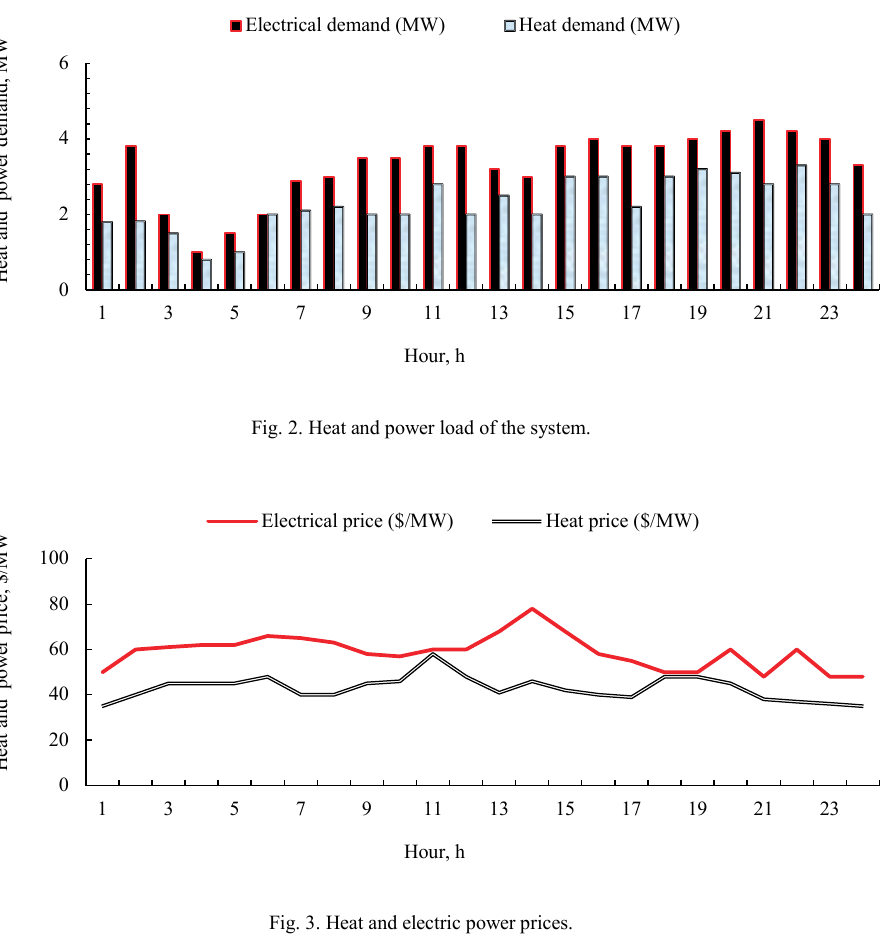
Fig. 3. Heat and electric power